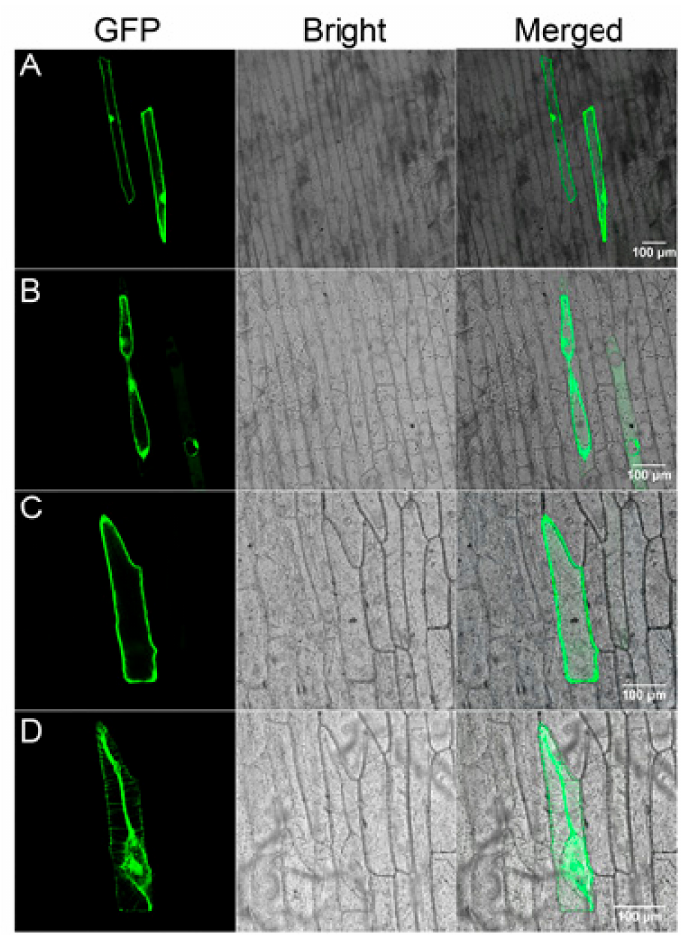
Figure 8. Subcellular localization of Gs5PTase8 in onion epidermal cells. Green fluorescence protein (GFP) ( A, B ) and Gs5PTase8-GFP ( C, D ) driven by CaMV 35S were transiently expressed in onion epidermal cells and observed before ( A, C ) or after ( B, D ) plasmolysis. GFP fluorescence, bright-field and merged images are shown. Scale bars indicate 100 µ